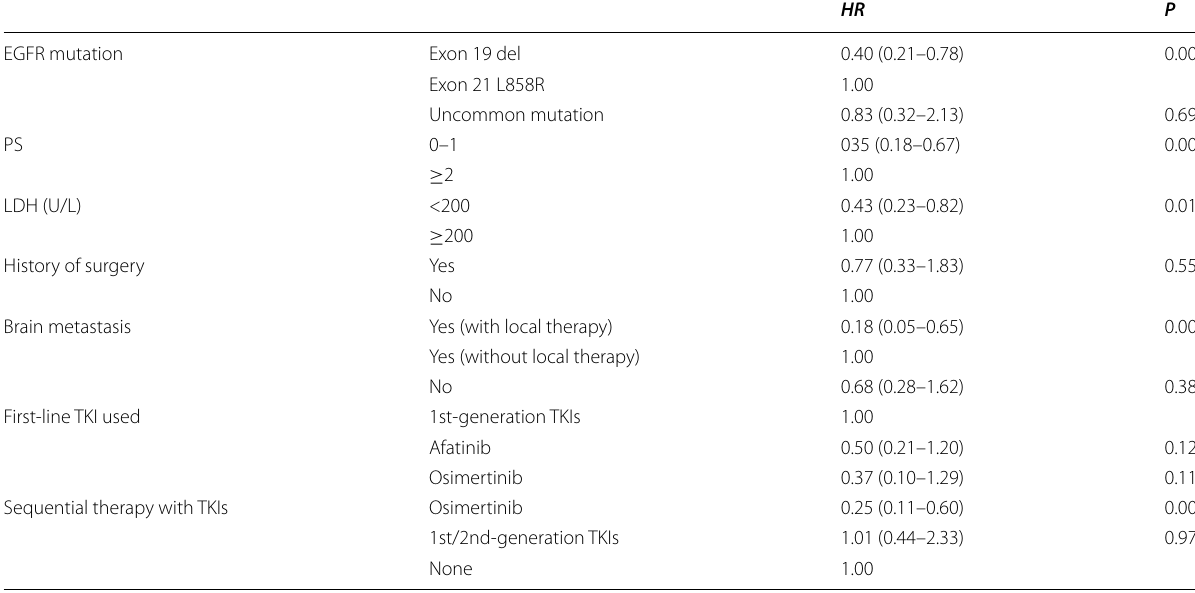
Table 3 Associations of the patient characteristics with the OS (Cox proportional hazards